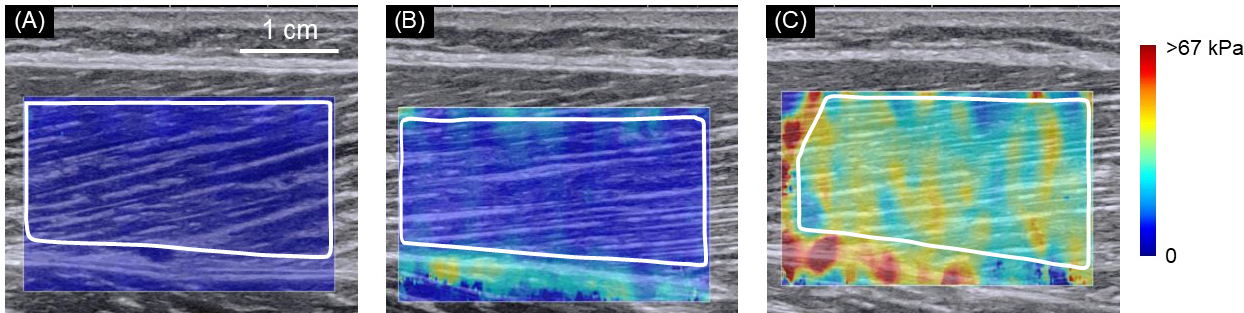
Figure 2. Typical examples of ultrasound shear wave elastographic (SWE) images. Typical examples of ultrasound SWE images with the knee fully extended in the supine position ( A ), the knee flexed to 90° in the seated position ( B ), and the knee fully flexed in the seated position ( C ). The colored region represents the shear wave speed map, with the scale to the right of the figure. The area drawn in solid white lines is the region of interest for the determination of shear modulus.